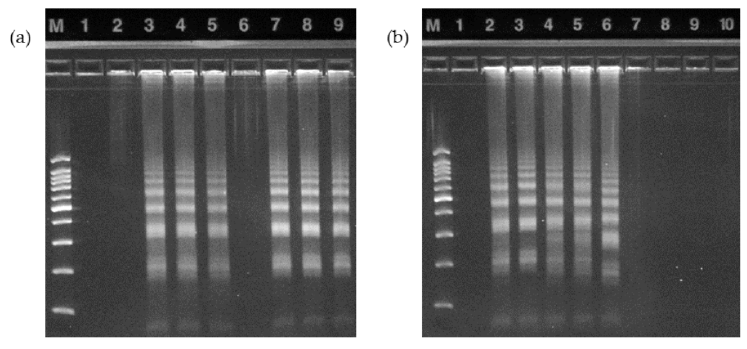
Figure 10. Electrophoresis results. M: DNA size marker (SizerTM-100bp, INtRON Bio., Seongnam-si, Korea); 1st lane: Negative (no DNA template in sample tube). ( a ) Electrophoresis photograph of 10-fold dilution; 2–10th lanes: LAMP product with an initial concentration of 10 8 CFU/mL; 10-fold dilution occurs with increasing location number. ( b ) Photograph comparing the electrophoresis results of the proposed LOD and the existing spin column; 2nd lane: LOD reference (sample solution without target DNA); 3–5th lanes: LAMP reaction using the LOD; 6th lane: Spin-column reference (sample solution without target DNA; same as 1st lane); 7–9th lanes: LAMP reaction using the spin column.